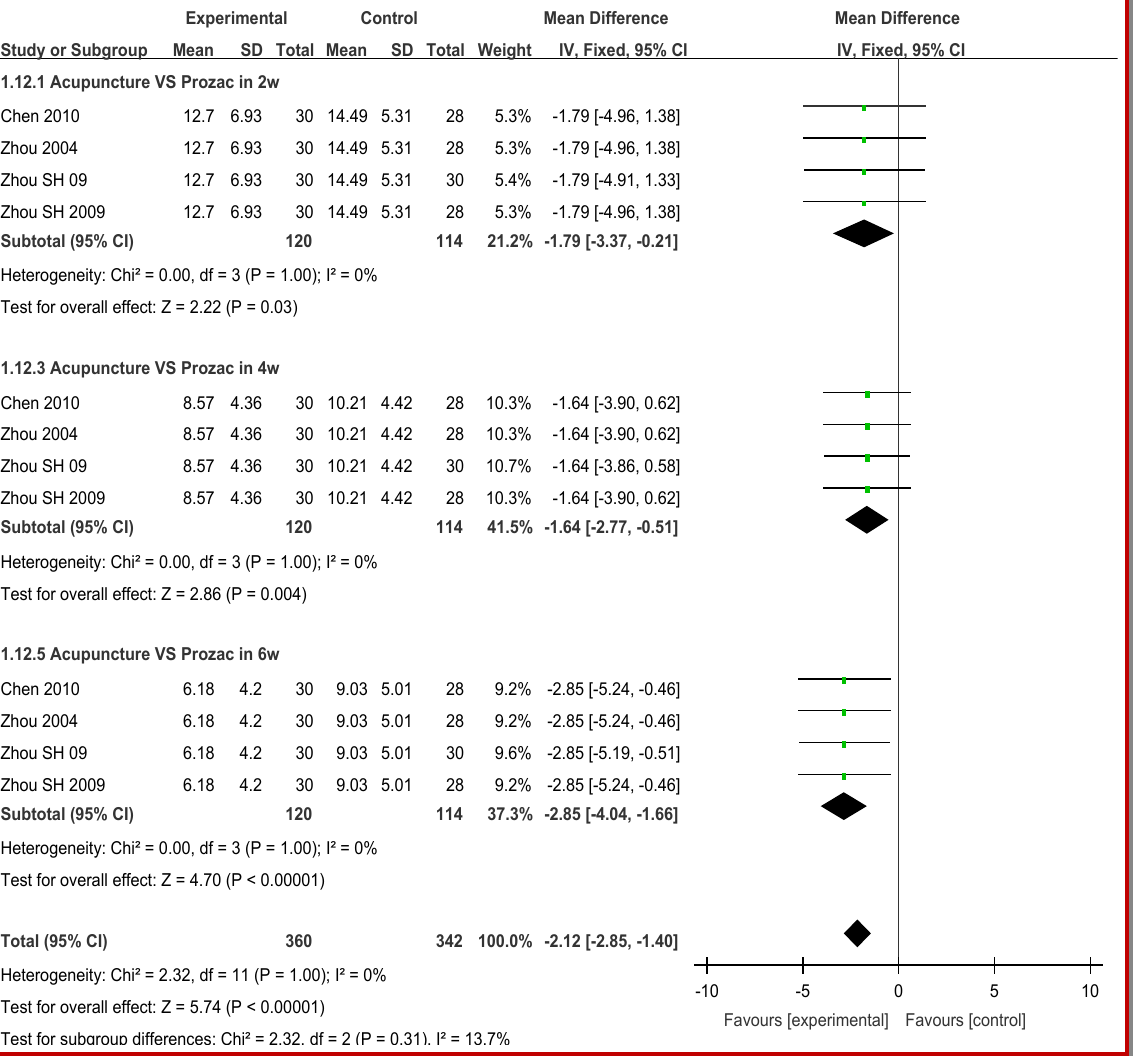
tions, 2 trials used TESS score. The remaining 6 trials reported the number of adverse reactions and described the symptoms. treatment, 10 cases (2.7%) had adverse reactions. There were two cases of adverse reactions happened in 1 trial.